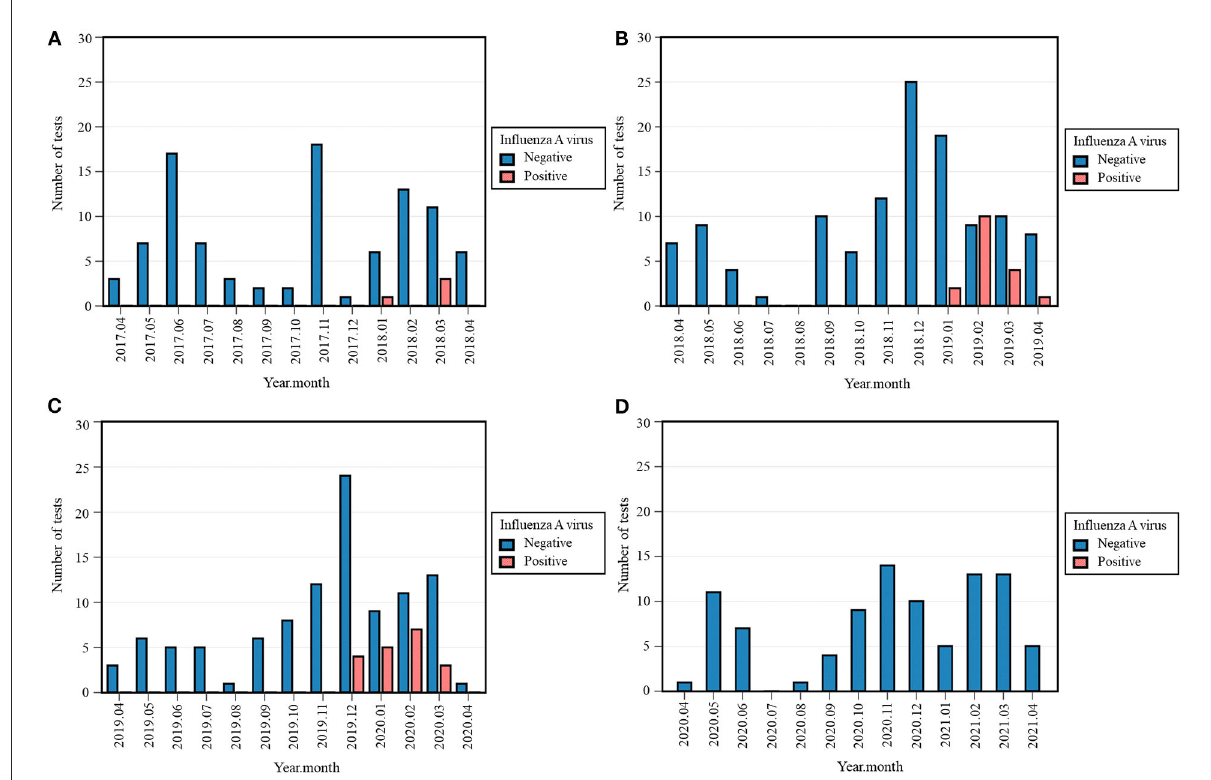
FIGURE2 Monthly occurrence of influenza A virus (IAV) per year: 2017-2018 (A) , 2018-2019 (B) , 2019-2020 (C) , 2020-2021 (D) . Monthly occurrence was defined as the number of positive tests per month. Each 12-month period started on April 16th and ended on April 15th of the following year.